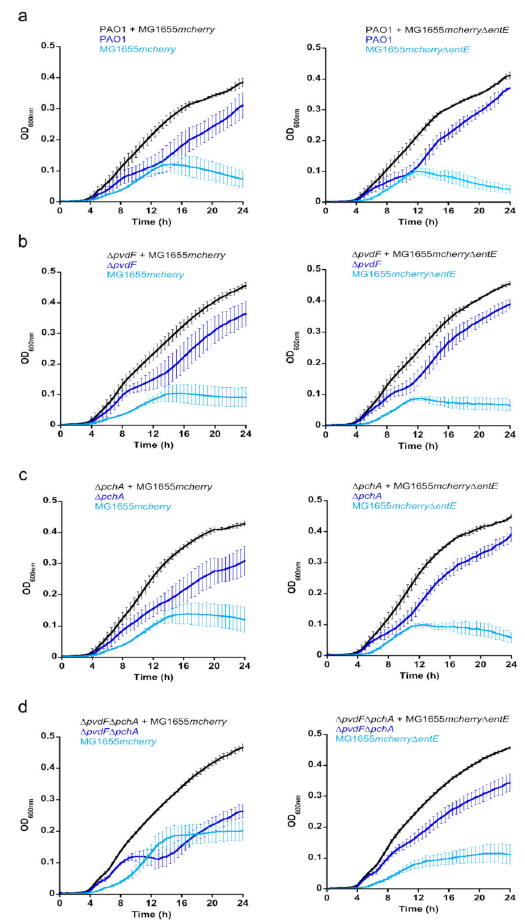
Figure 5. Co-cultures between P. aeruginosa able to produce either PVD or PCH and E. coli . Co- cultures of P. aeruginosa strains producing, or not, either PVD, PCH, or both siderophores (PAO1 ( a ), ∆ pvdF ( b ), ∆ pchA ( c ) and ∆ pvdF ∆ pchA ( d )) with E. coli producing, or not, ENT (MG1655 mcherry or MG1655 mcherry ∆ entE , respectively). All cultures were carried out in CAA medium supplemented with 0.6% glycerol at 30 ◦ C. For the co-cultures, both strains were mixed at an OD of 0.005 and the bac- terial growth monitored by following the OD at 600 nm. MG1655 mcherry and MG1655 mcherry ∆ entE both carry a plasmid encoding mCherry and the fluorescence of this protein was followed at 610 nm (excitation: 570 nm). These values at 610 nm were used to identify the portion of the OD signal at 600 nm in the co-cultures due to E. coli and P. aeruginosa . All the data are the means of three independent